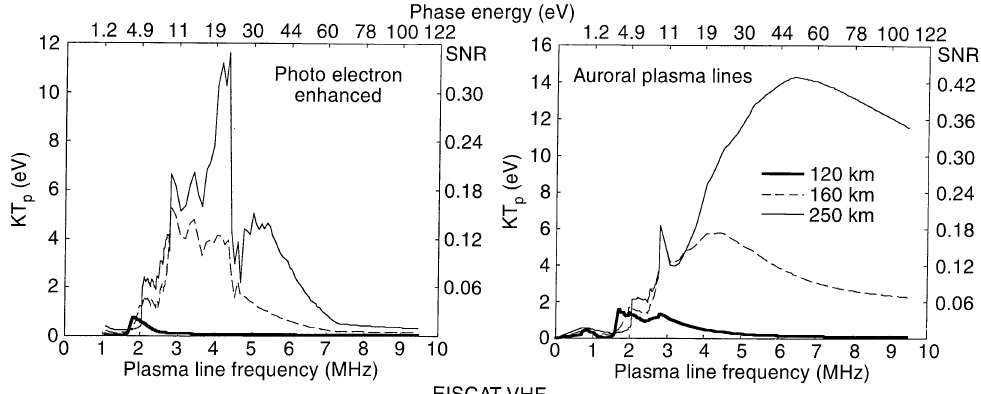
text for details). The lower x - axis gives the plasma line frequency, while the upper gives the phase energy for the resonant electrons (for comparisons with Fig. 1)